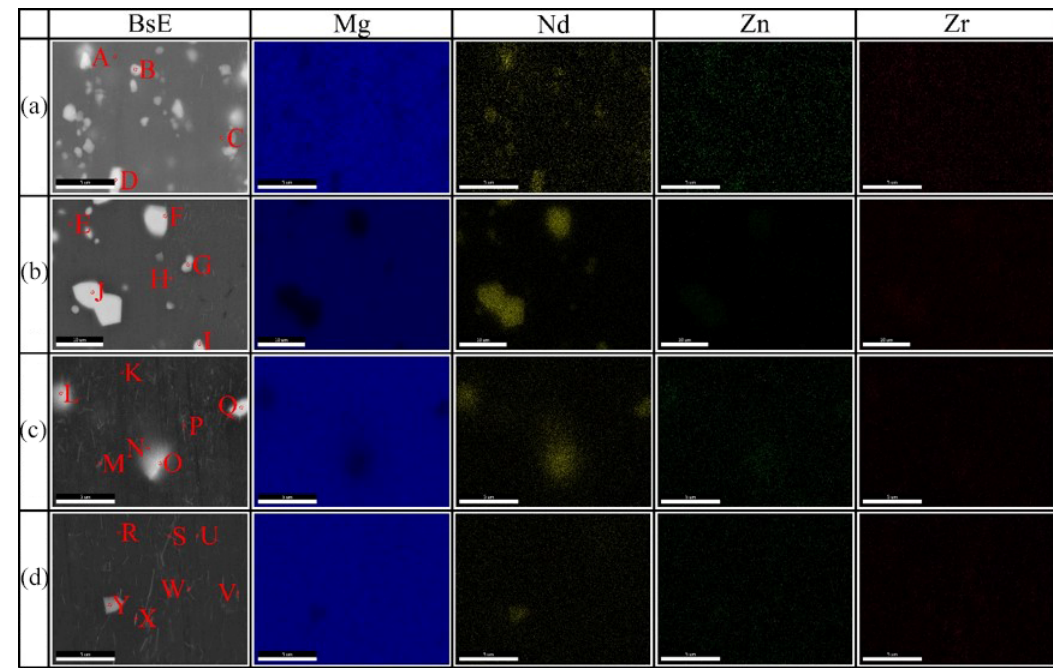
Figure 10. The SEM-EDS element mapping of the initial extruded state and after holding at 500 °C for 8 h, 12 h, and 24 h, respectively. ( a ) As-extruded, ( b ) 500 °C × 8 h, ( c ) 500 °C × 12 h, ( d ) 500 °C × 24 h Table 2. Chemical composition of intermetallic phases in Figure 10 (in at.%). Element Content (at.%) Area